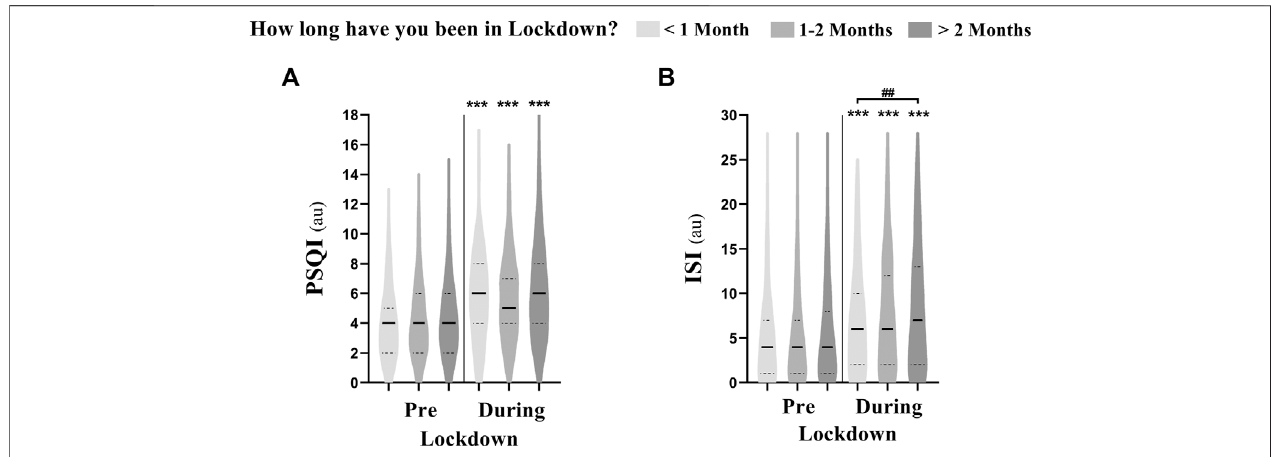
FIGURE 3 | Violin plot showing the difference in (A) Pittsburgh sleep quality index (PSQI) and (B) insomnia severity index (ISI) between athletes who were in lockdown for < 1 month ( n = 222), 1 – 2 months ( n = 389) and > 2 months ( n = 843). *** means signi fi cant within subject effect of the lockdown at p < 0.001. ### means signi fi cant between subject effect during-lockdown at p < 0.001. Signi fi cance is assessed by a mixed design ANOVA and the Bonferroni post-hoc test.